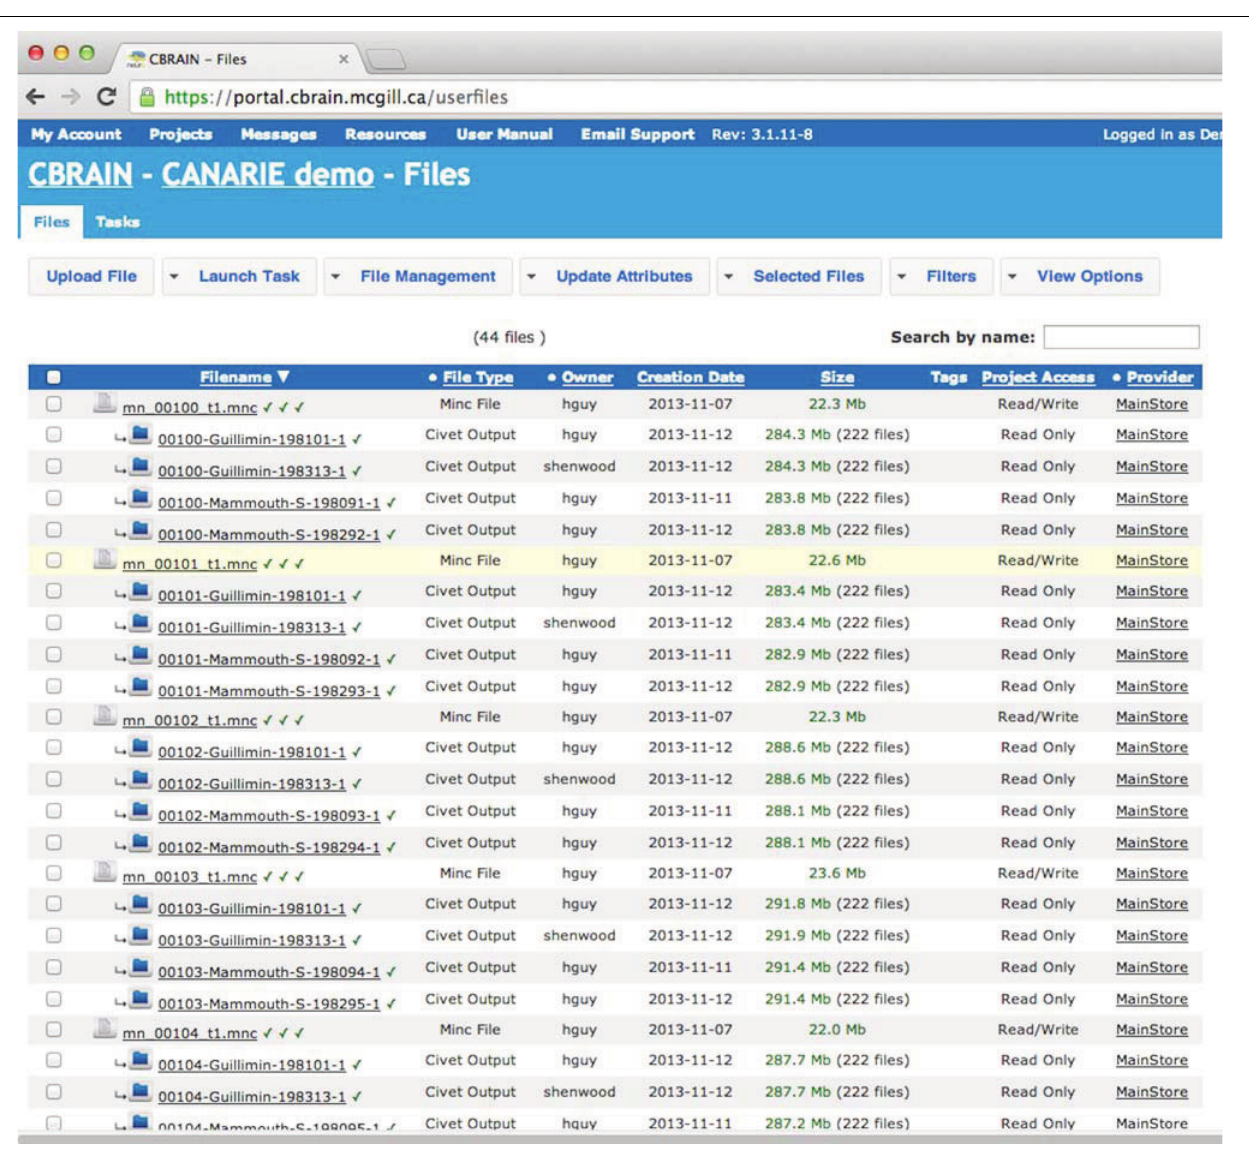
be performed through this page, although private data providers or SFTP transfers are preferable for large data. Synchronization information of a file or collection over various caches and data providers is indicated by a symbol next to the file